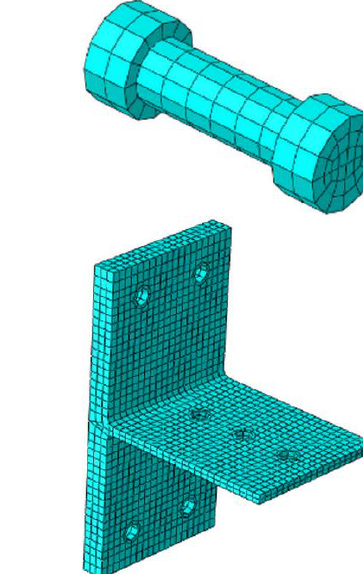
Table 2. Comparing experimental results with numerical modeling results.